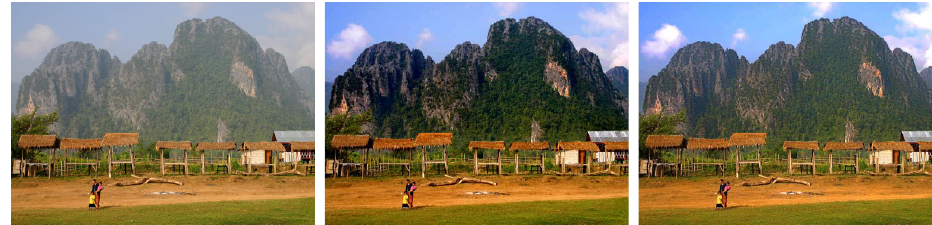
Figure 7. Visual comparison with the Meng et al.’s method on the “Mountain” image: ( Left ) the input haze image; ( Middle ) Meng et al.’s result; ( Right ) our result.